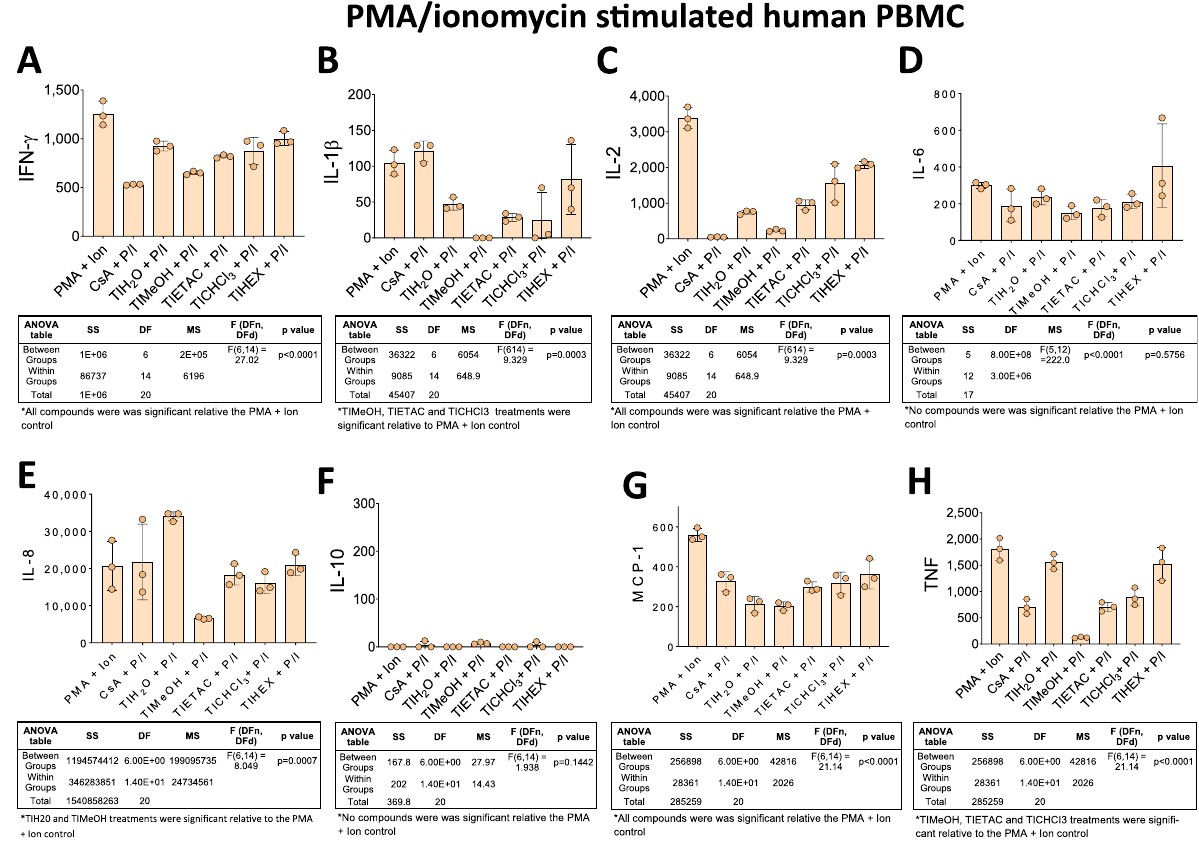
Figure 4. Handroanthus impetiginosus (Mart. ex DC.) Mattos (Bignoniaceae) bark-derived compounds can suppress cytokine release of PMA/Ionomycin-activated PBMC. PBMC were combined with TIH 2 O aqueous extracts, TIMeOH methanolic extracts, TIETAC ethyl acetate extracts, TICHCl 3 chloroform extracts and TIHEX hexane extracts for 24 h. Individual cytokine levels of ( A ) IFN-γ, ( B ) IL-1β, ( C ) IL-2, ( D ) IL-6, ( E ) IL-8, ( F ) IL-10, ( G ) MCP-1 and ( H ) TNF were quantified by CBA as detailed in the “Material and methods” section. The data is the mean of three replicates ± SD. Associated ANOVA Tables are presented beneath the line graphs and significant or nonsignificant (*) results are shown beneath the